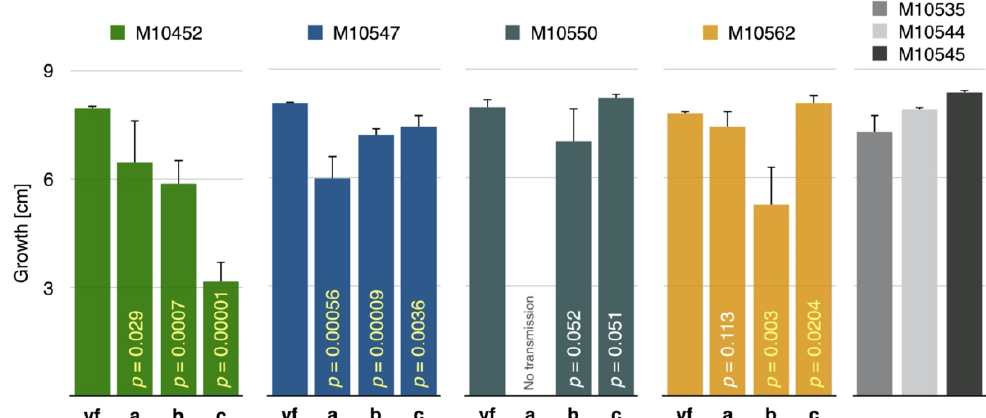
Figure 8. Growth rate of CnFGV1-positive and virus-free isogenic strains of Cryphonectria naterciae . Compared are isogenic virus-free strains (= vf) with experimentally infected recipients M10452, M10547, M10550, and M10562 of C. naterciae . Donors are a = M10535, b = M10544, and c = M10545. Gray columns show the growth of donor strains. Column height represents growth after 7 days of incubation. Vertical black lines indicate the standard deviation of three culture replicates, and vertical yellow p -numbers highlight significant growth differences between the virus-free and each infected strain. White p -numbers are nonsignificant considering a critical value of p < 0.05.